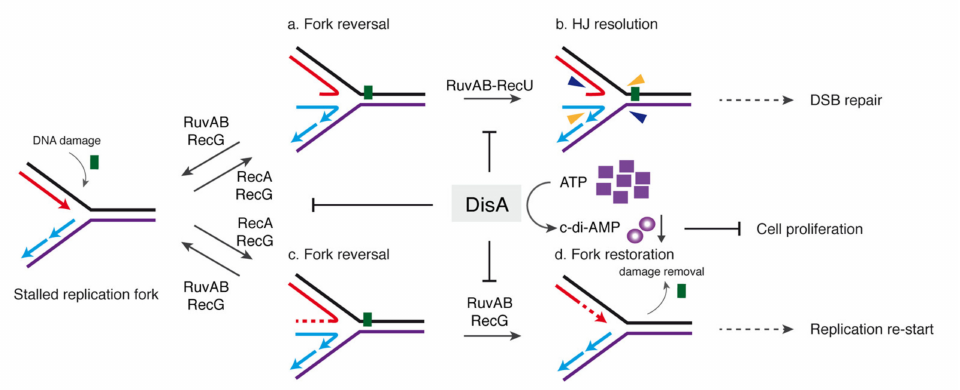
Figure 7. Proposed DisA mode of action in the presence of RecU and RuvAB. An unrepaired DNA lesion on the leading-strand template (green square) causes blockage of replication fork movement. Fork reversal by the RecA or RecG remodeler may form an HJ DNA structure and this process is inhibited by DisA. In the upper panel, DisA suppresses fork reversal and HJ resolution by the RuvAB-RecU resolvasome ( a , b ), avoiding the formation of a one-ended DSB. In the lower panel, DNA synthesis extends the regressed fork to convert it into an HJ-like structure, and fork restoration is catalyzed either by RuvAB or RecG ( c , d ), followed by damage removal by specific repair mechanisms. This process is also downregulated by DisA. DisA bound to HJ DNA decreases c-di-AMP synthesis, indirectly increasing (p)ppGpp synthesis and inhibiting cell